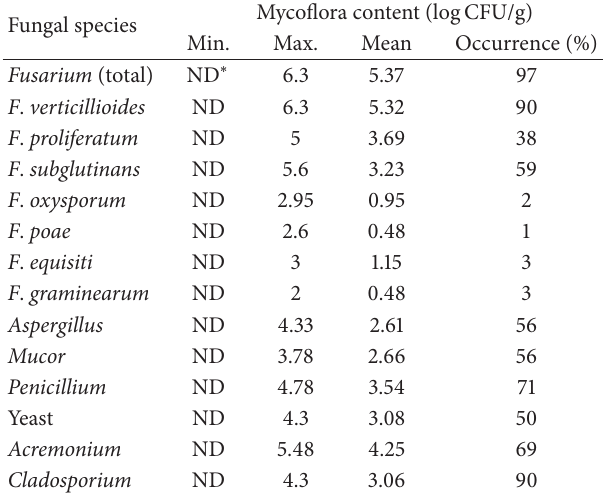
Table 2: Fungal contamination of 117 maize